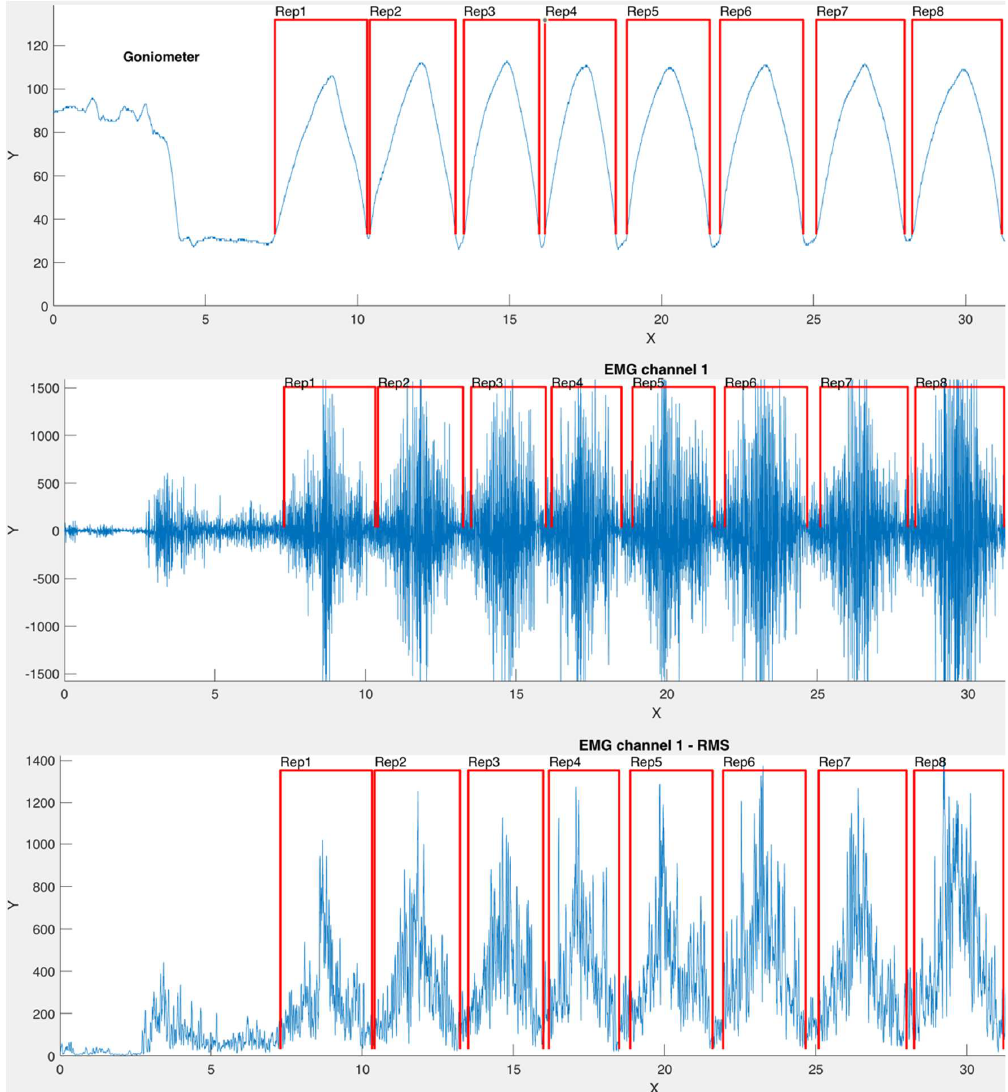
Figure 2. Example of the angular values and EMG tracing from a participant during the bench press exercise at 0°. The first to the third rows represent the angular values of elbow flexion–extension, raw EMG, and root-mean-square (RMS) EMG of the pectoralis major (sternal portion), respectively.